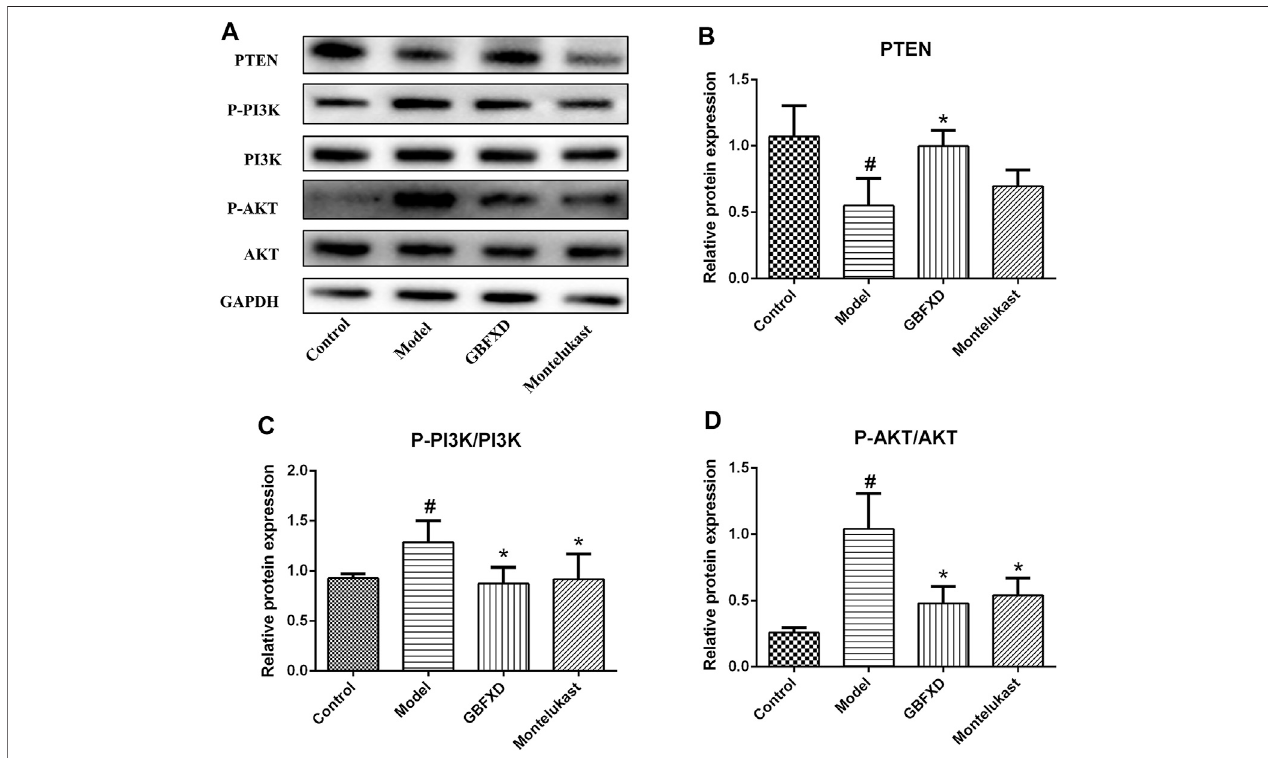
FIGURE7| Effect ofGBFXDonPI3K/AKTsignaling pathway. (A) Westernblottingwasused todetect theprotein expressions ofPTEN,P-PI3K,PI3K,P-AKT,and AKT. (B – D) Quanti fi cationofPTEN,P-PI3K/PI3KandP-AKT/AKT.Valuesarepresentedasmean ± SD( n (cid:2) 3or4micepergroup).# p < 0.05comparedtocontrolgroup, and * p < 0.05 compared to model